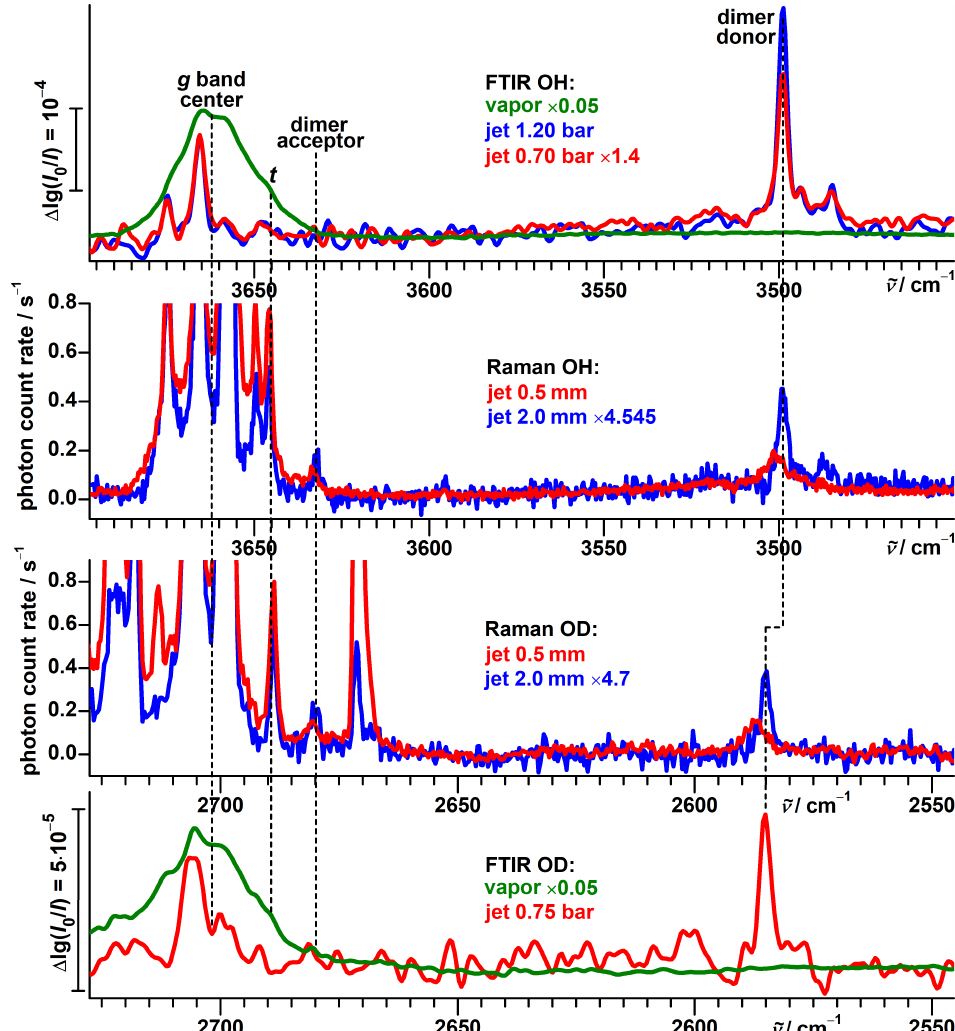
Figure 14. Comparison between FTIR and Raman spectra of protiated (top traces) and deuterated (bottom traces) (+) - α -fenchol. The wavenumber axes for the OH and OD stretching regions are aligned according to 0.73778 · ˜ ν ( OH ) = ˜ ν ( OD )